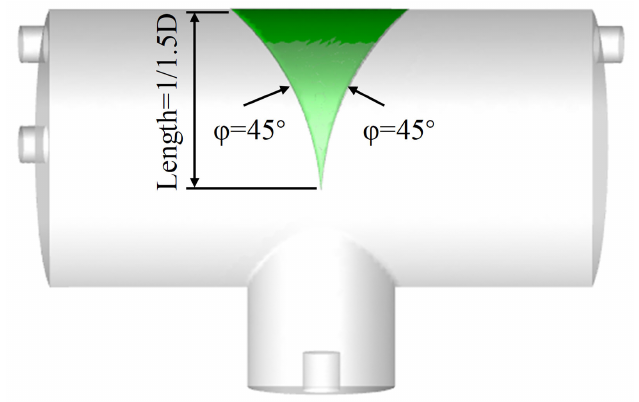
Figure 14. The “Y” − shaped middle diaphragm.